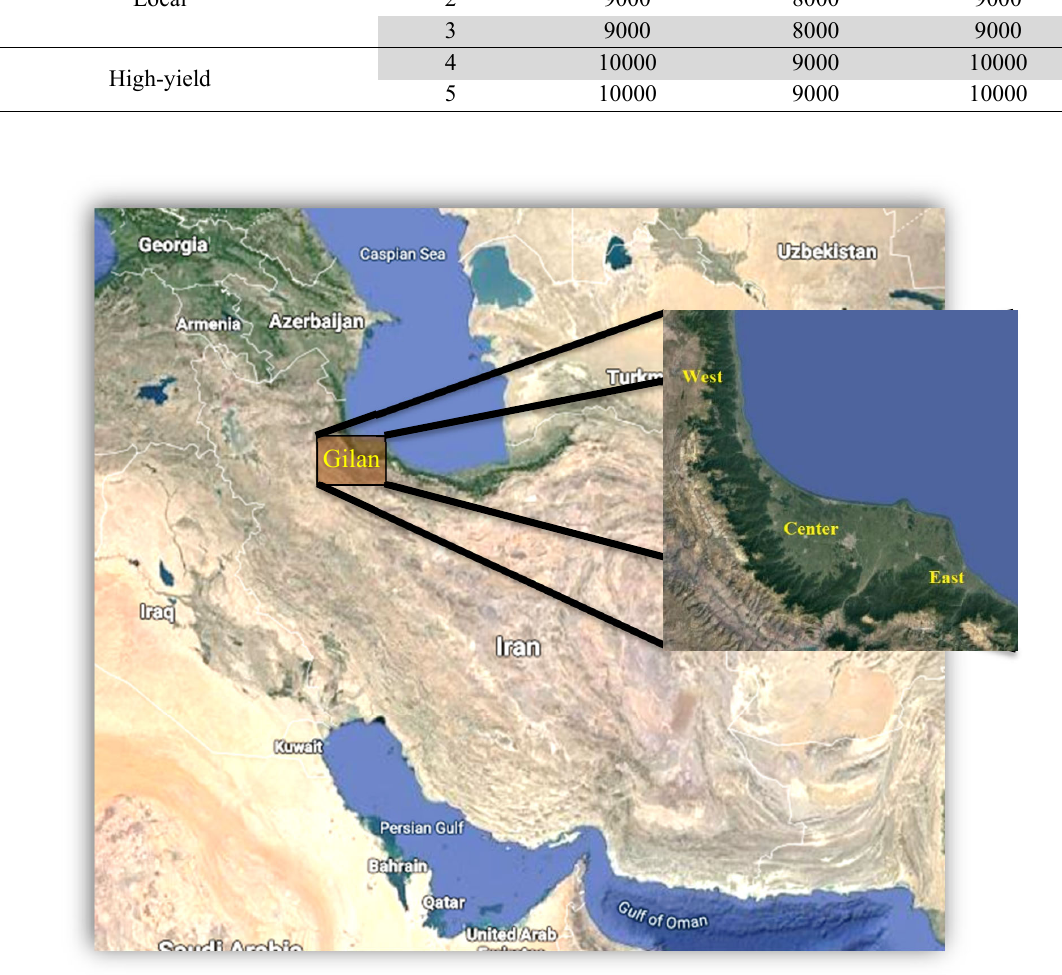
Fig. 2. Sections (regions) of Gilan province,